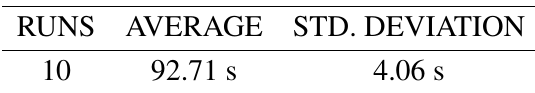
Table 4. Average and Standard Deviation for full exploration time in 10 runs using Avoid Kins Past + 10% wandering rate with 3